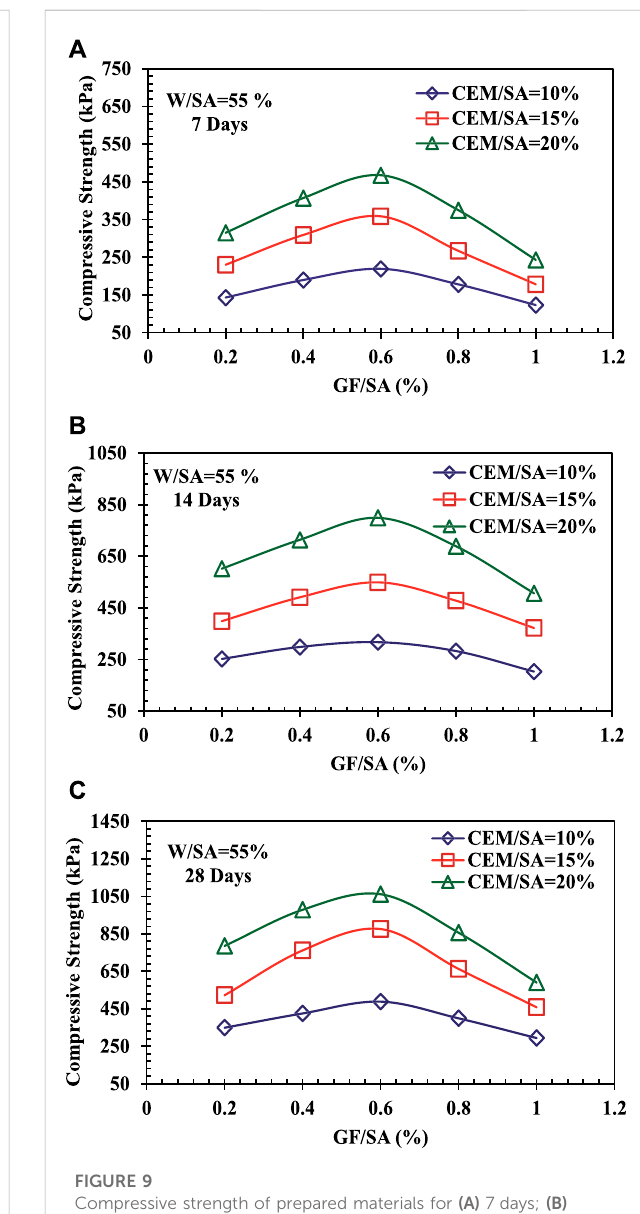
FIGURE 9 Compressive strength of prepared materials for (A) 7 days; (B) 14 days; and (C) 28 days with respect to mix